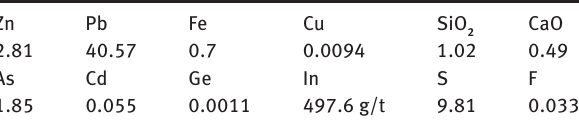
Figure 2: The schematic of microwave drying